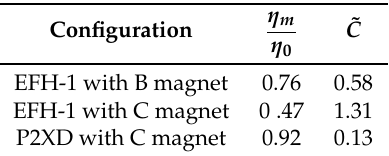
Figure 2. X-ray, phase-contrast image of magnetized bulk ferrofluid, showing (i) thread-like aggregates aligned with direction of applied uniform magnetic field; and (ii) falling spherical glass ball. Table 1. Measured magnetoviscosity factor, η m , and anisotropy factor ˜ C for the two applied field η 0 strengths (C magnet: 980 G, B magnet: 490 G) and types of ferrofluid (EFH-1, P2XD purified, see text) used in the